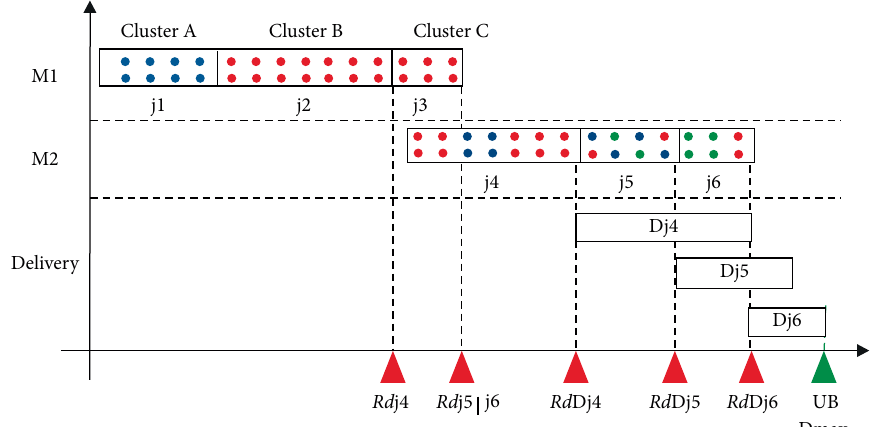
Figure 3: An upper bound solution example. The red triangles represent the release dates for each job. Furthermore, the green triangle represents the UB value.